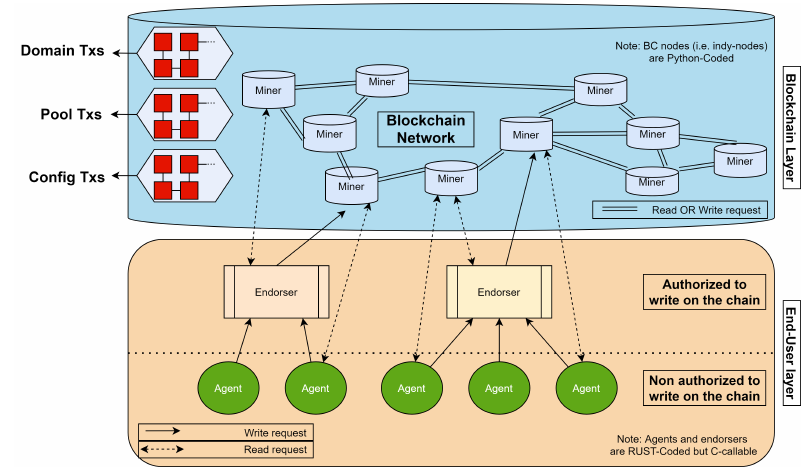
Figure 1. Our proposed blockchain architecture based on Indy [15].